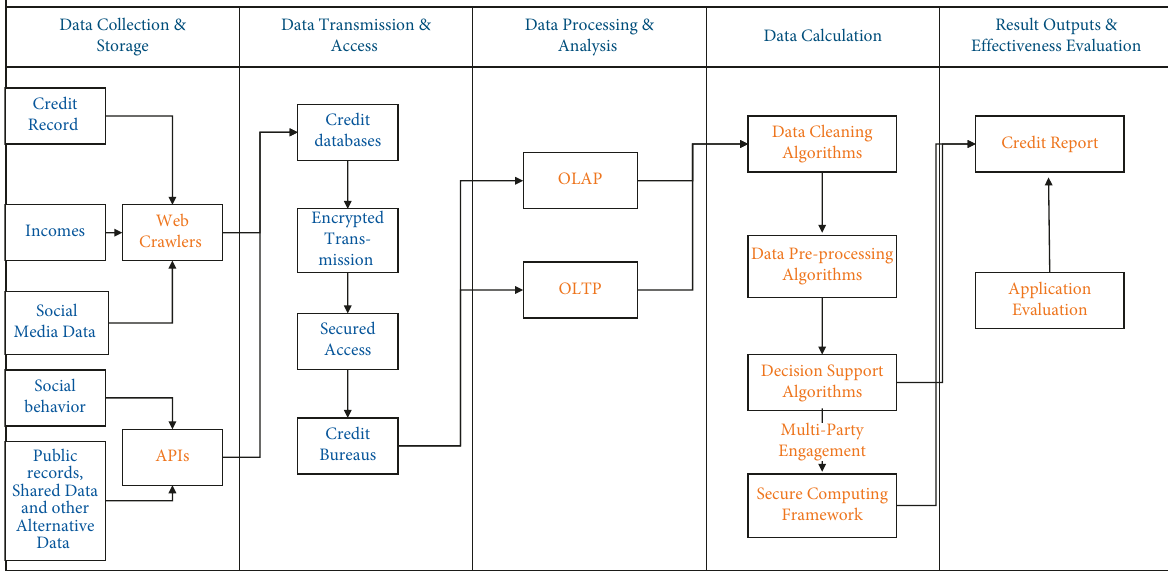
Figure 4: General process of modern credit